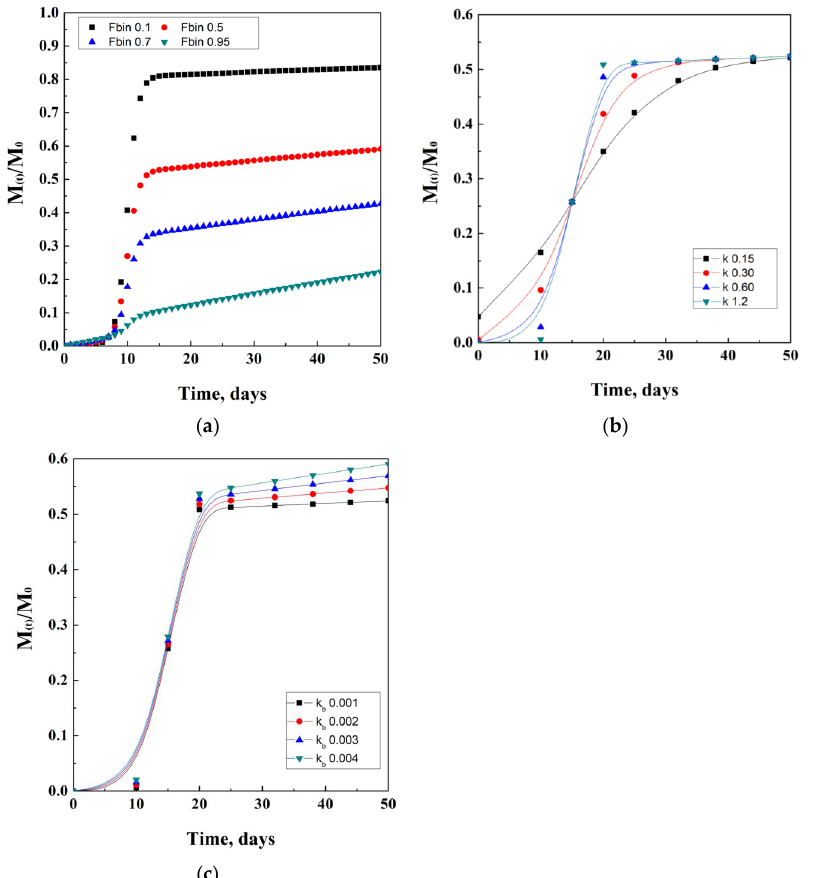
Figure 7. Corrigan model depending on the F bin coefficient ( a ), k degradation coefficient ( b ), and k b diffusion coefficient ( c ). diffusion coefficient ( c